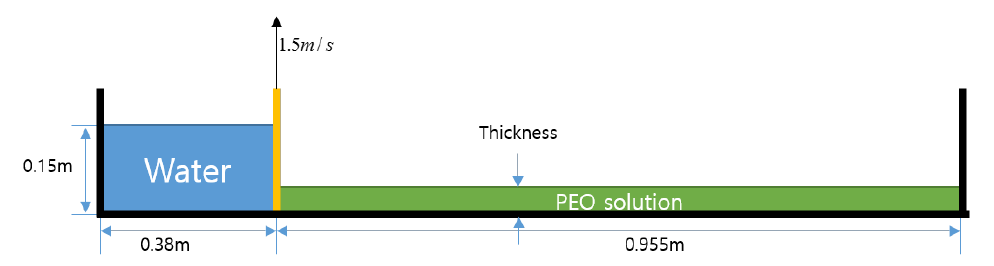
Figure 6. Schematic of the broken dam with soil bed.